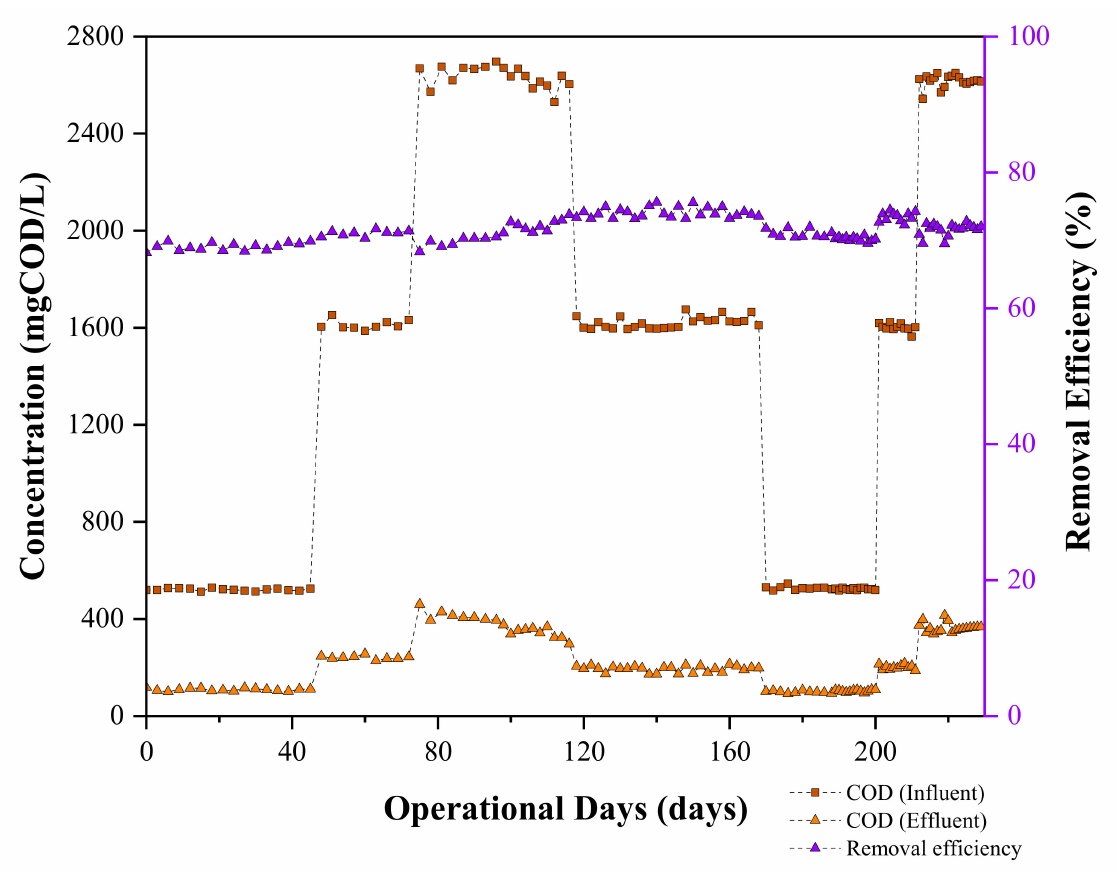
Figure 4. The experimental time course of CFBS in terms of COD concentrations and removal